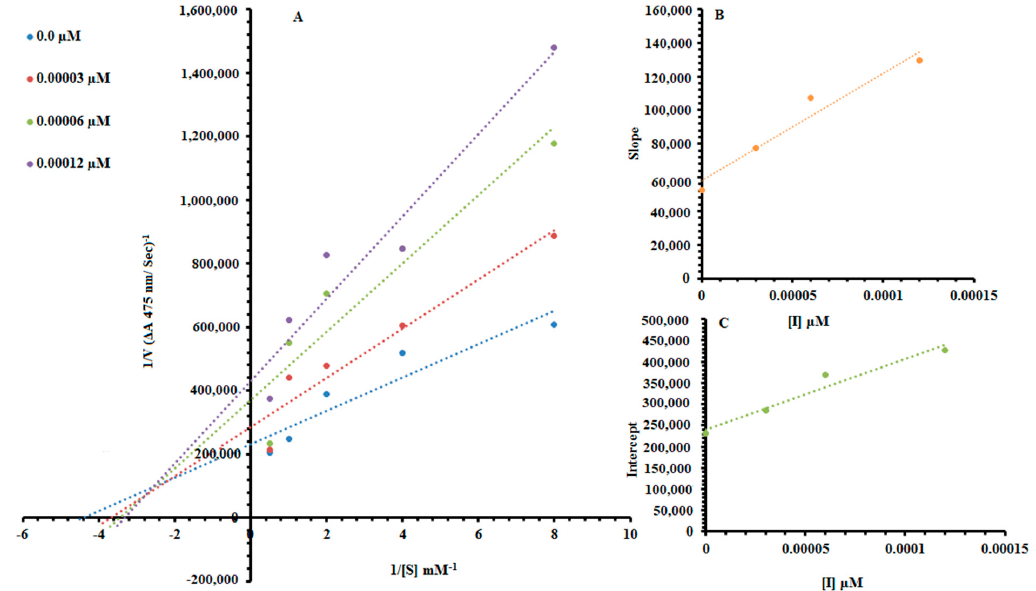
Figure 2. Lineweaver–Burk plots for inhibition of tyrosinase in the presence of 2-((4-methoxyphenethyl)amino)-2- oxoethyl cinnamate ( Ph6). ( A ) Concentrations of Ph6 were 0, 0.001 and 0.002 µM, respectively. Substrate L - DOPA concentrations were 0.125, 0.25, 0.5, 1 and 2 mM, respectively. ( B ) The insets represent the plot of the slope. The lines were drawn using linear least-squares fit.